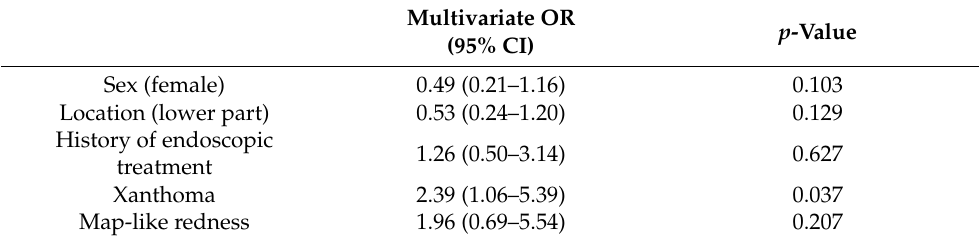
Table 3. Multivariate